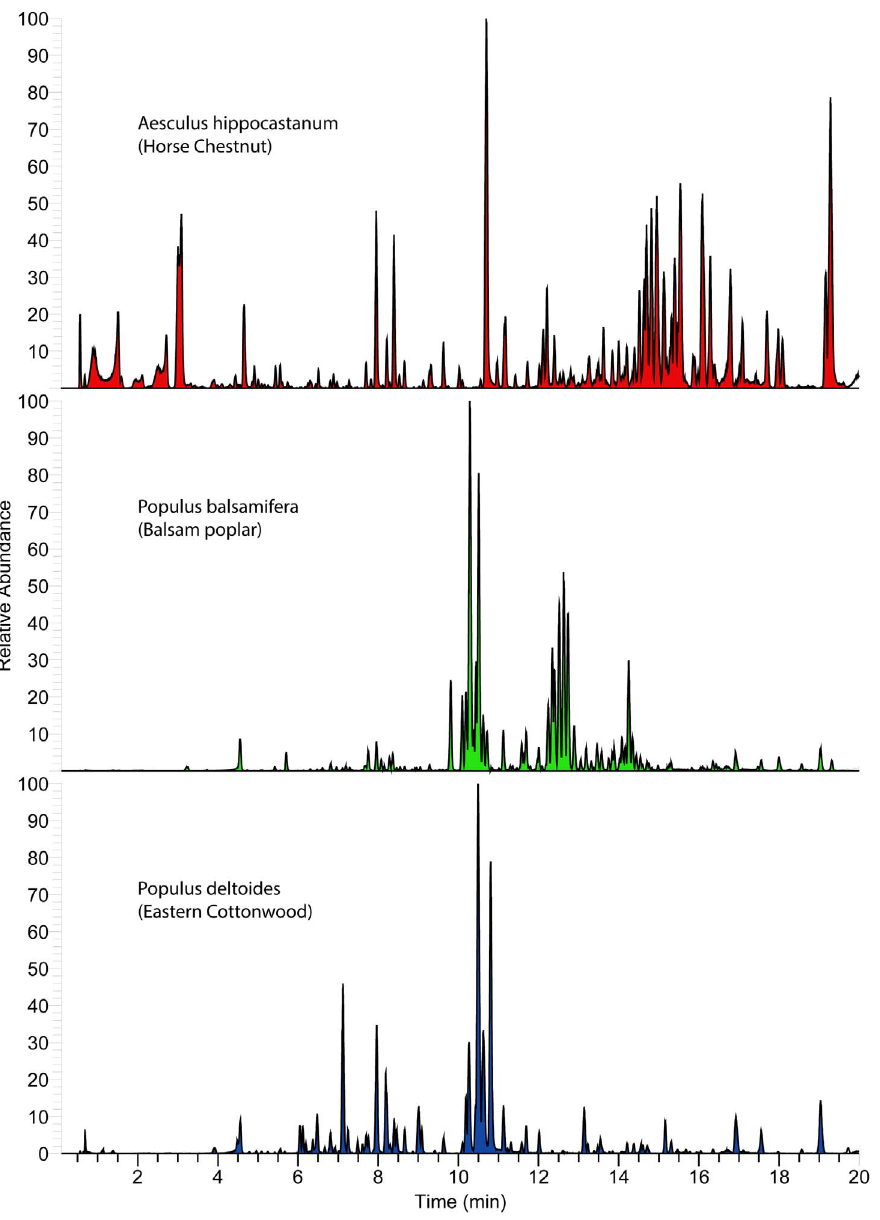
Figure 2. Resin metabolite diversity of studied angiosperms. Base-peak negative-ion chromatogram (‘‘fingerprints’’) of resin collected from individual Populus spp . (poplar) and Aesculus hippocastanum (horse chestnut) within 2 miles of the study